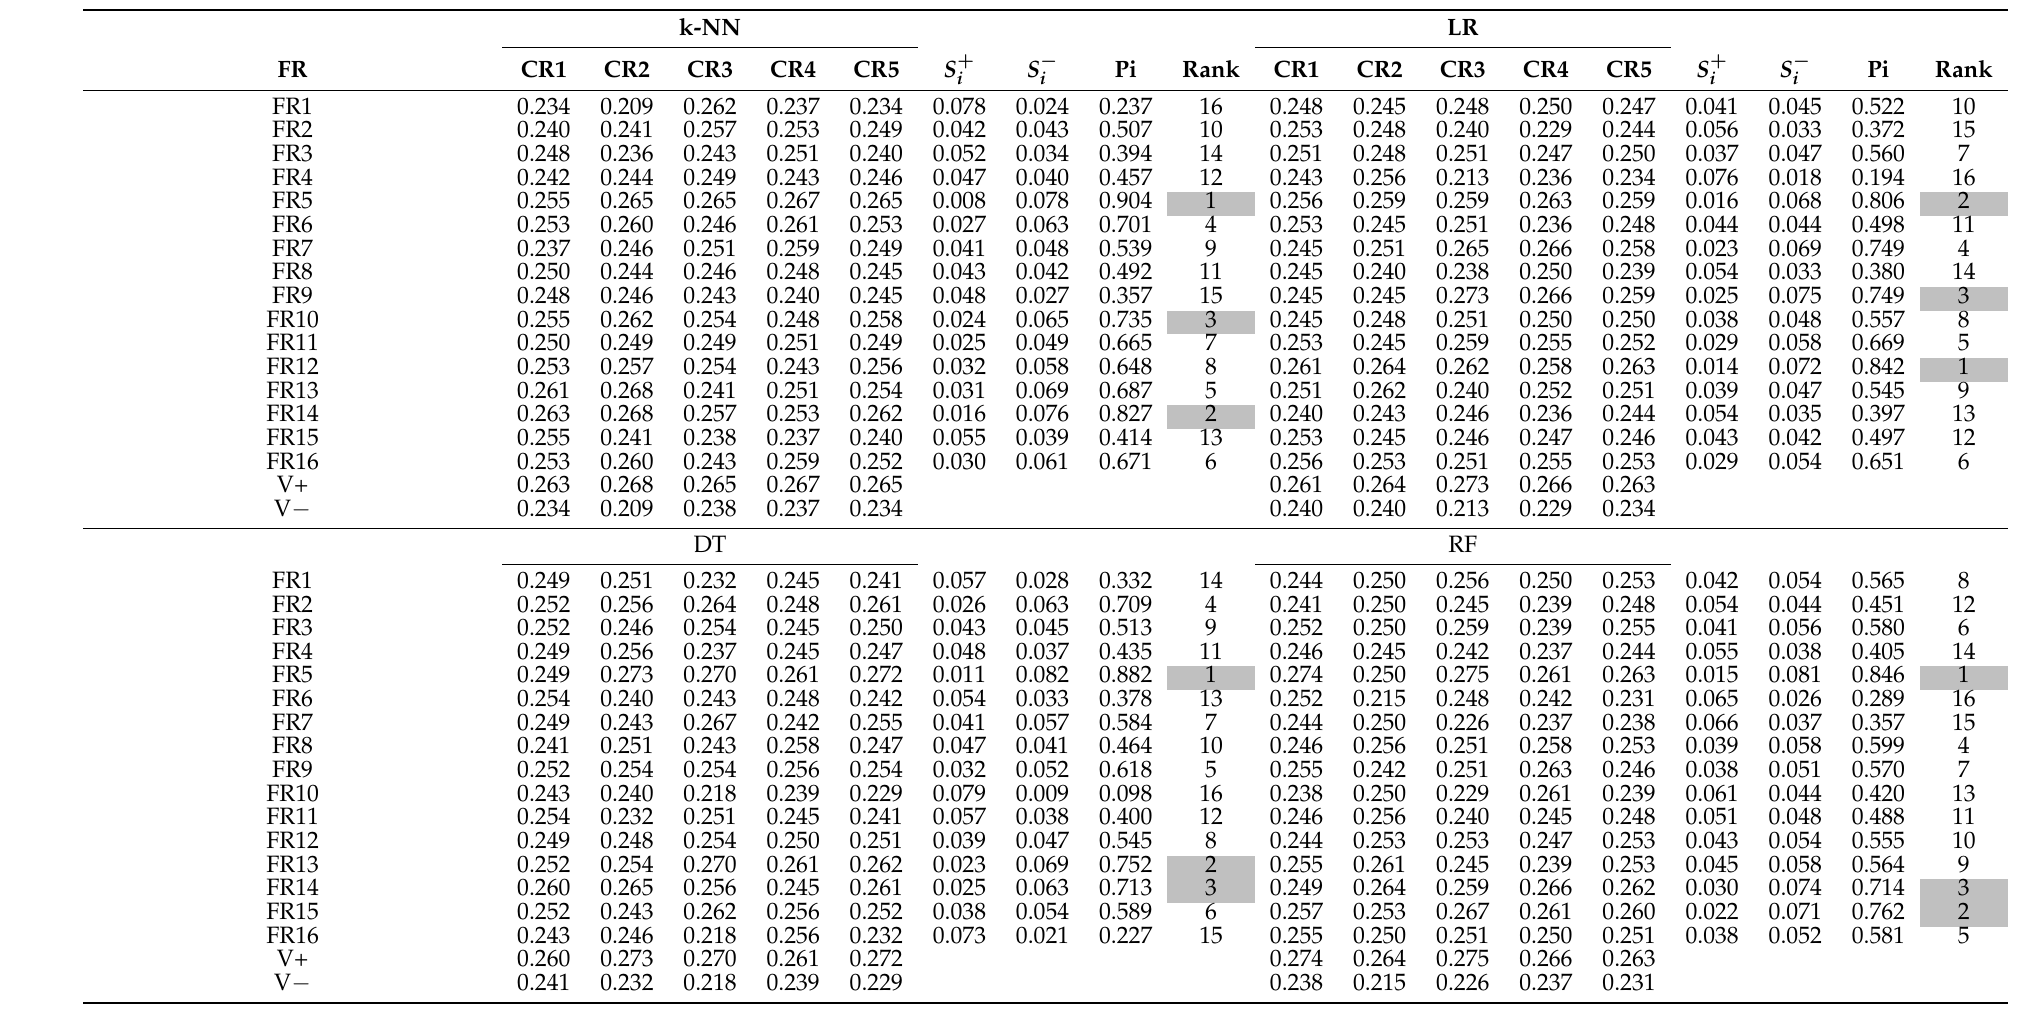
Table 5. Results of TOPSIS for Brain Tumor Dataset with Ranking of Feature Reduction Sequence using Dataset